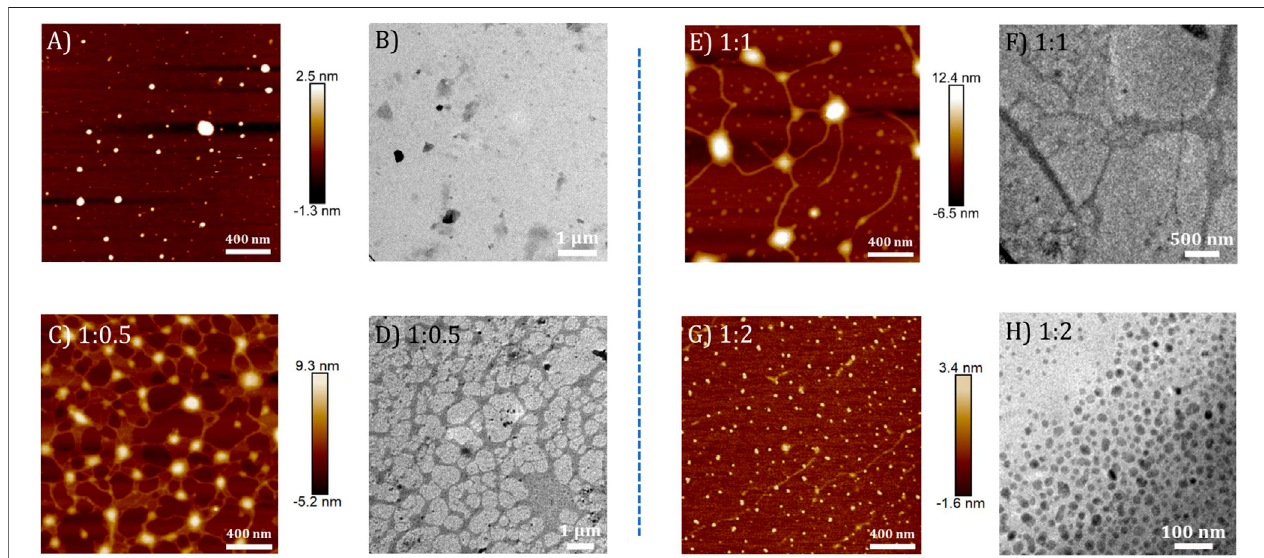
FIGURE 6 | Schematic representation of the CT-DNA interaction and condensation process by TPE-V molecules.